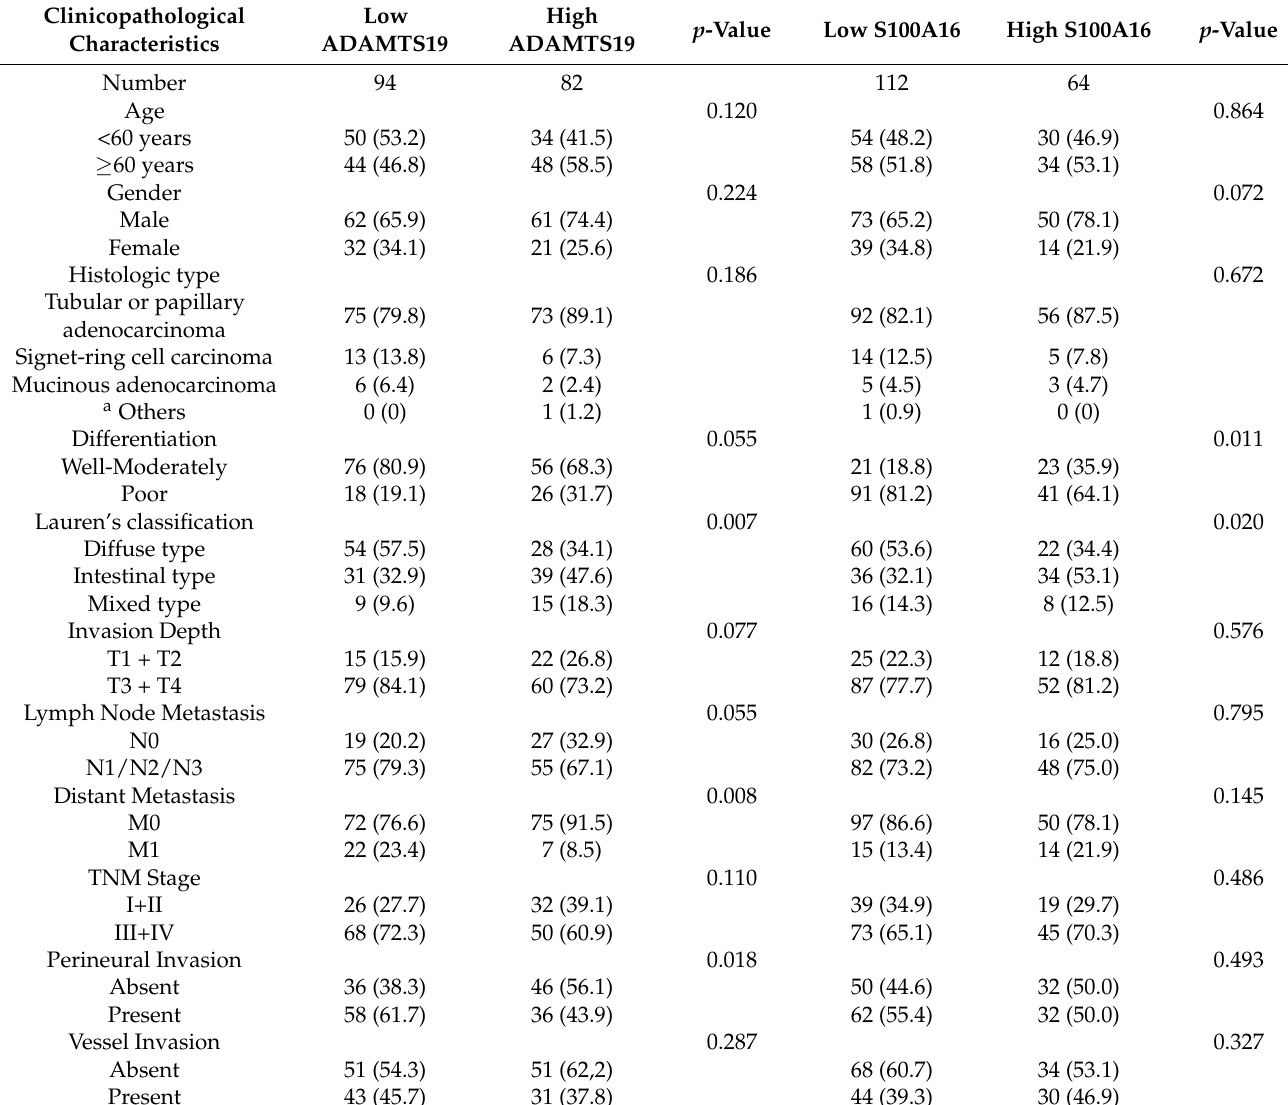
Table 1. Correlation between ADAMTS19, S100A16 expression and clinicopathological characteristics of gastric patients ( n =